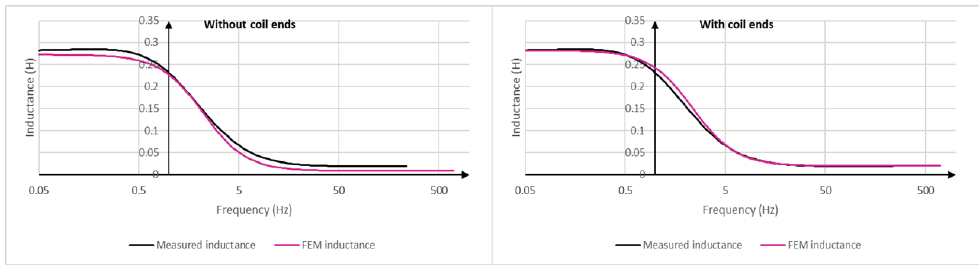
Figure A2. Inductance seen from the stator versus frequency with and without coil ends, rotor terminals